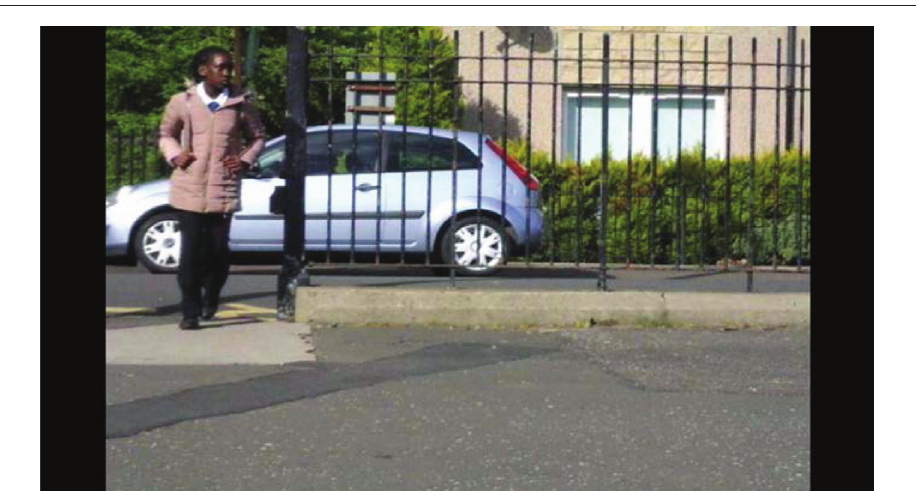
Figure 3: Khadija arrives at school in See You Tomorrow After a series of shorter, more exploratory, exercises, students were tasked by CCAJ’s ‘Rules of the Game’ to make a short film ‘where the story is interrupted at a certain moment, when a character finds their freedom through playing, which allows them to escape from the confines of their everyday